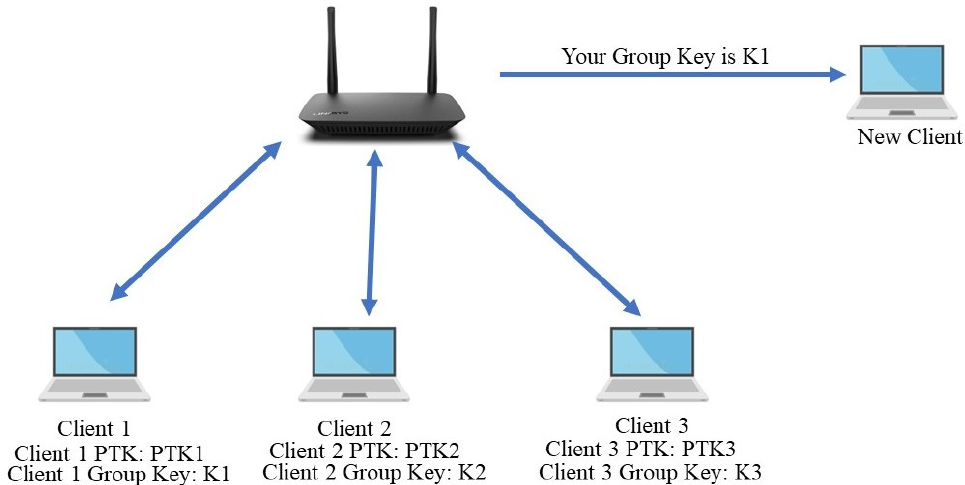
Figure 5. Each client has same copy of GTK in wireless